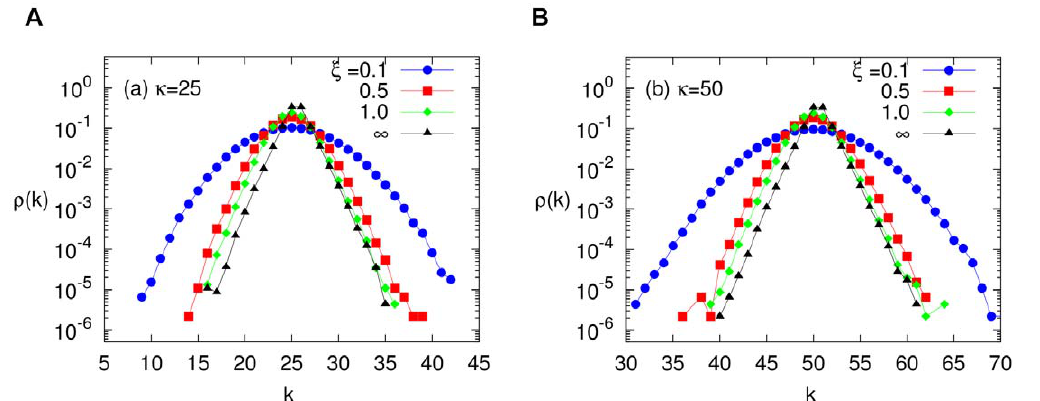
Figure 1. Degree distribution of preferred degree networks. Networks with N ~ 5000 nodes and various inflexibility parameters j (see Eq. 1). Panels (a) and (b) corresponds to k ~ 25 and k ~ 50 respectively. The j ? ? corresponds to the totally inflexible individuals and results in a Laplace distribution.